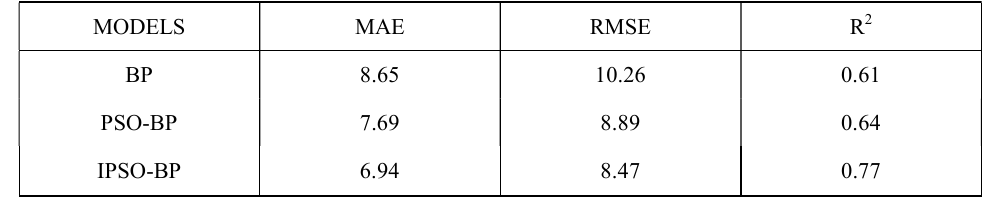
The accuracy evaluation data of the three models is shown in Table 2. It can be seen from the table that the BP model can be used to predict the PM 2.5 concentration, but the prediction accuracy is not high. The prediction accuracy has been improved by the particle swarm optimization algorithm. The MAE and RMSE of the model are 6.94 and 8.47, respectively, which are smaller than the PSO-BP model and the BP model. The R 2 of the model is 0.77, which is larger than the PSO-BP model and the BP model. It is proved that IPSO-BP can improve the prediction accuracy of PM 2.5 concentration.